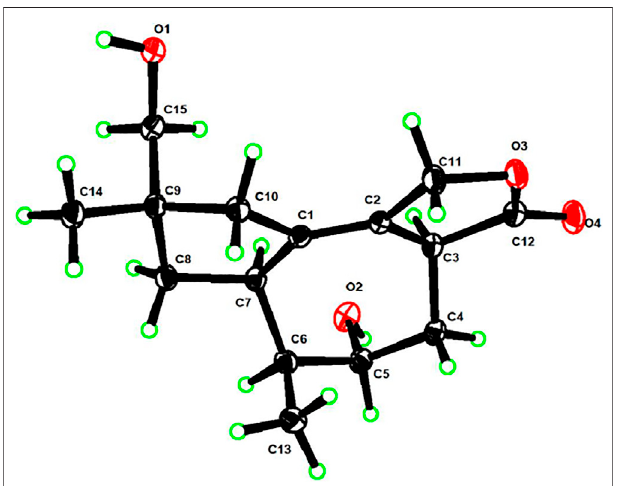
FIGURE 3 | Perspective ORTEP drawing for 1 .